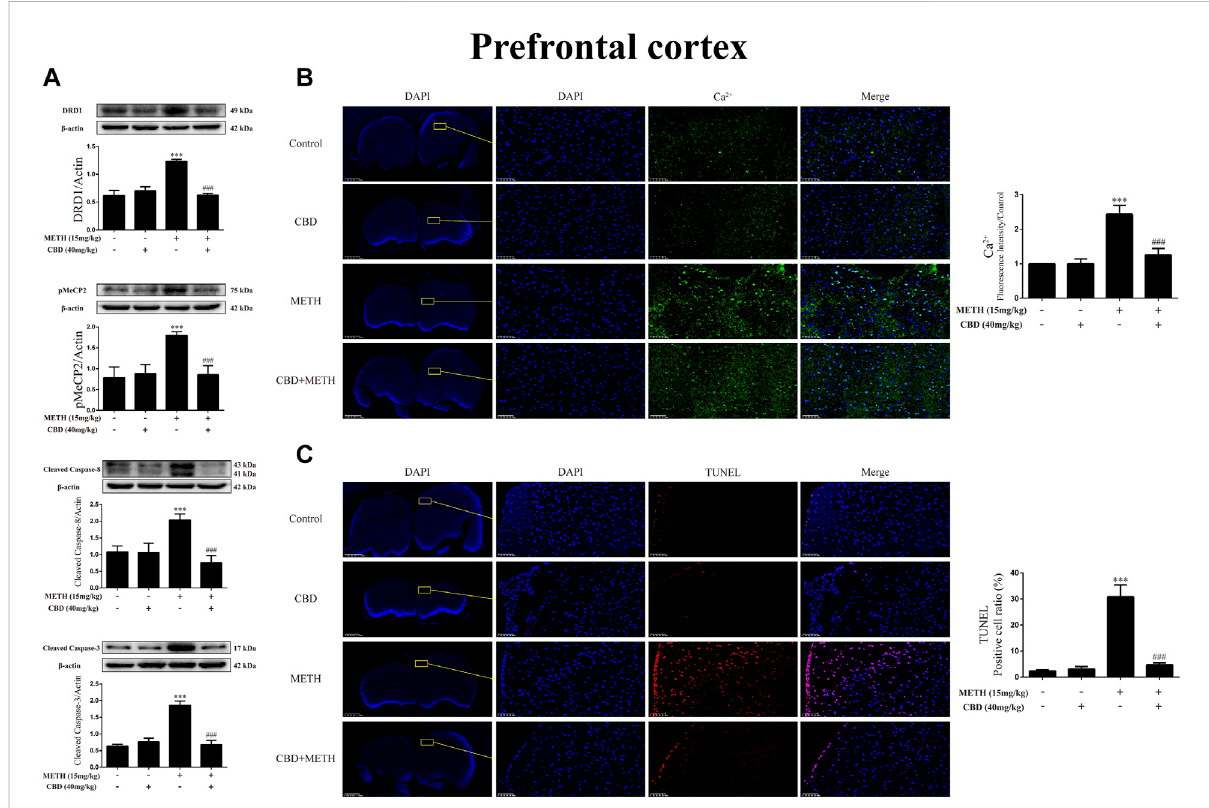
FIGURE 10 Protein, intracellular Ca 2+ , and apoptosis levels in prefrontal cortex of rats repeatedly exposed to CBD and/or METH. (A) Levels of DRD1, pMeCP2, and apoptosis-related proteins in prefrontal cortex. (B) Intracellular Ca 2+ level in prefrontal cortex. (C) Apoptosis level in prefrontal cortex. *** p < 0.001 compared with control group, ### p < 0.001 compared with METH group; Tukey HSD post-hoc comparison after signi fi cant